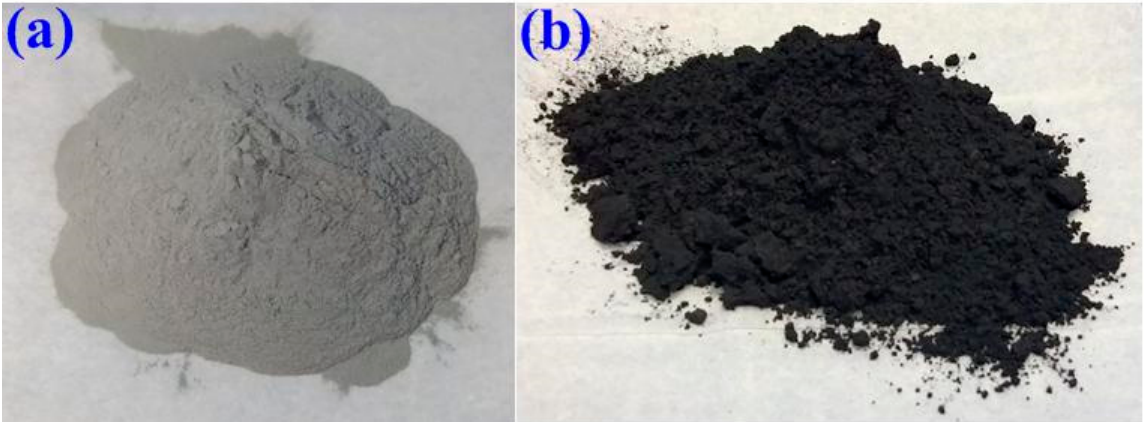
Figure 1. Photos of the ( a ) aluminum (Al) and ( b ) graphite (G) powders. Phase identification was carried out by X ‐ ray diffraction (XRD) (D8 ADVANCE, Bruker Inc., New Taipei City, Taiwan). X ‐ raying was performed in the geometry of a parallel beam with Cu K α radiation. In addition, the chemical composition of the